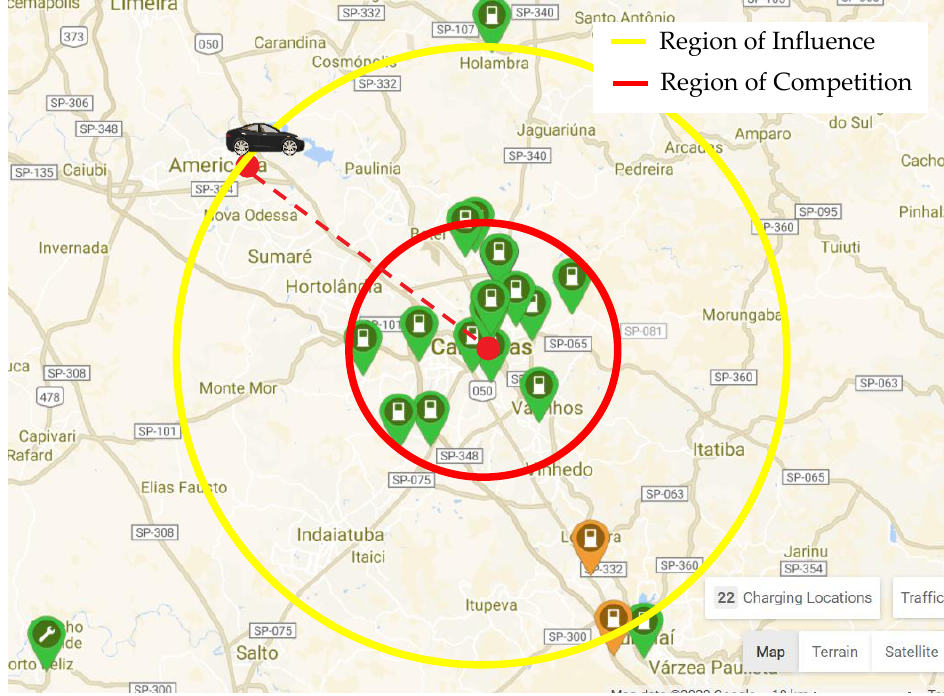
Figure 15. EV Charging Stations in the competition region. Source: Plugshare (Adapted).